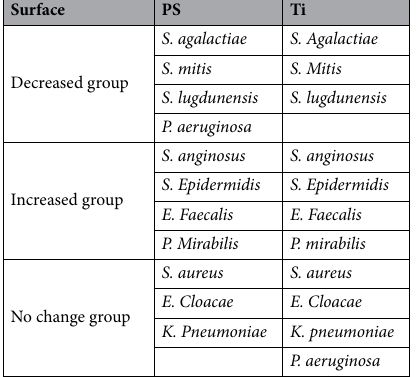
Table 2. Grouping according to epigallocatechin gallate (EGCG)-induced changes in biofilm formation on PS or Ti. Each group (Decreased, Increased, or No change) was assigned according to EGCG’s effect on biofilm